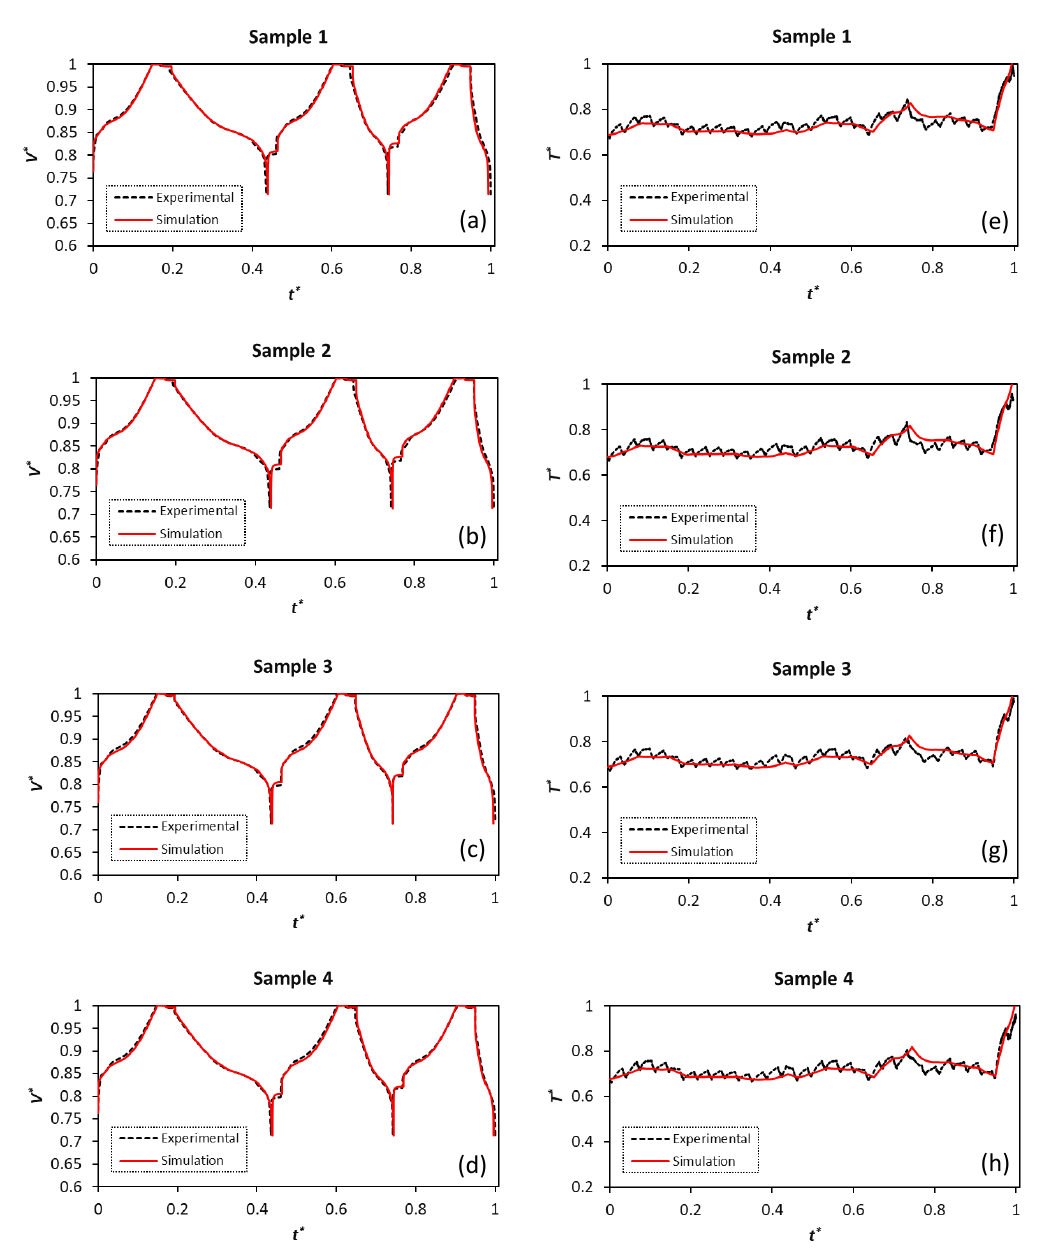
Figure 7. Cycling calibration optimization results for samples 1-4. ( a – d ): Voltage profiles; ( e – h ): Temperature